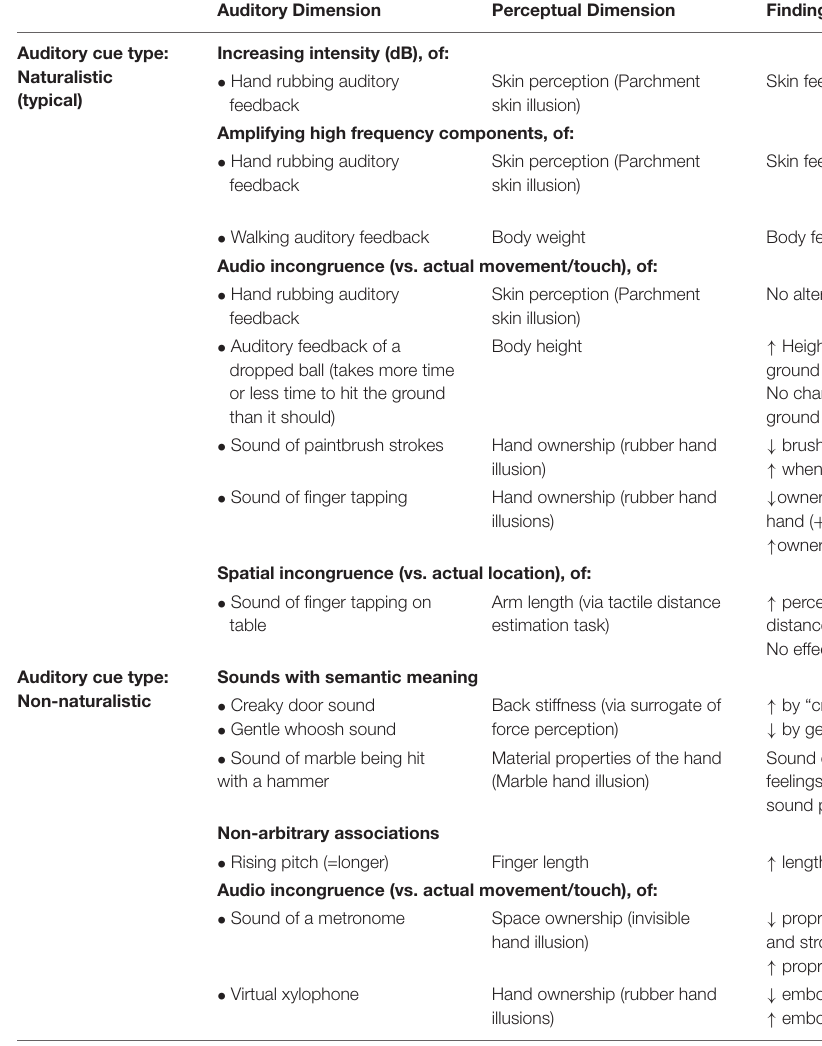
TABLE 1 | Summary of the effects of non-veridical auditory cues on body perception. Auditory Dimension Perceptual Dimension Findings